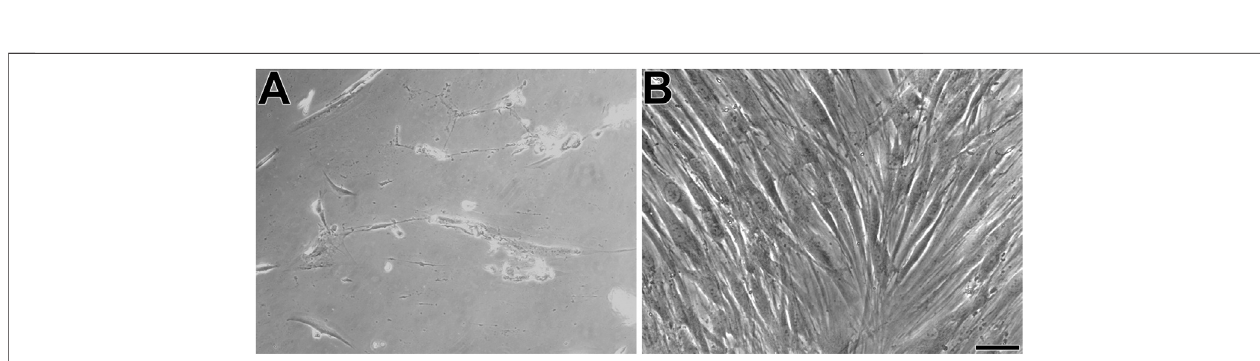
FIGURE 3 | Phase-contrast microscopy displays hPLF (A) and immortalized human periodontal fi broblasts (hPLF-hTERT) (B) , both cell lines with spindle-shaped phenotype. Scale bar: 100